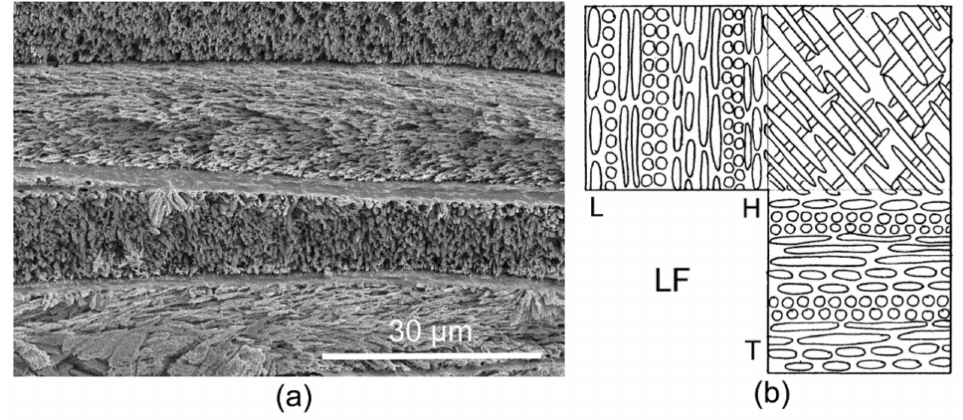
Figure 5. LF structure in the tube of Cruzigera websteri . ( a ) Transverse section, inner part of the tube, polished and etched with acetic acid. ( b ) Schematic line drawing of the LF